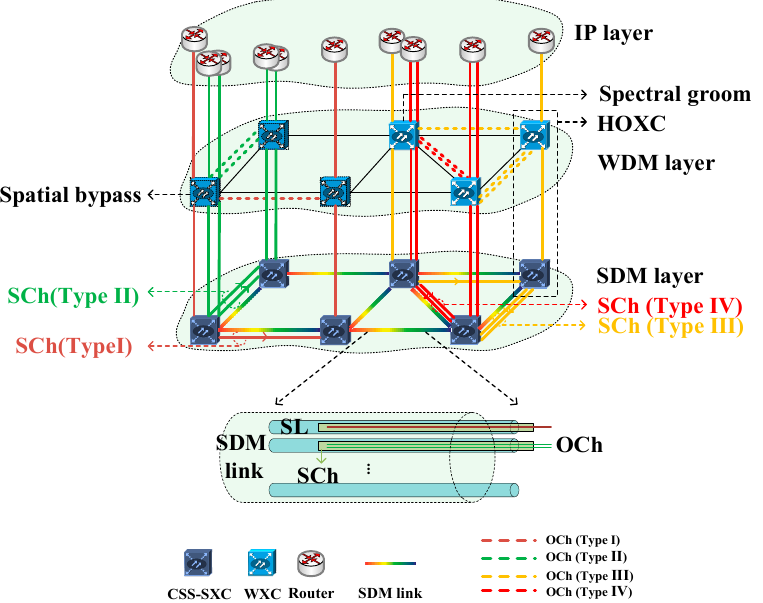
Figure 1. Spatial channel network (SCN) model.